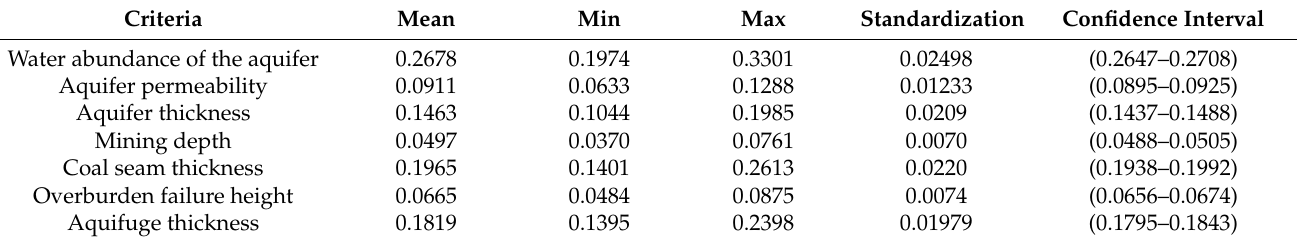
Table 1. The criteria weight statistics.